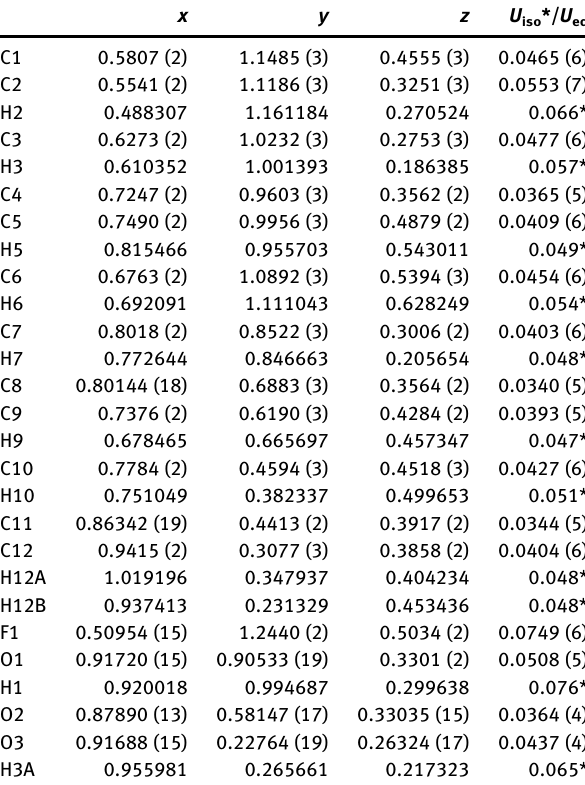
Table  : Fractional atomic coordinates and isotropic or equivalent isotropic displacement parameters (Å 